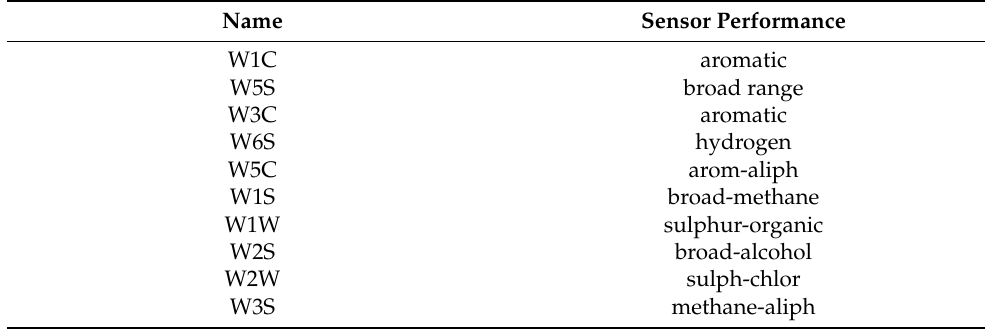
Table 2. Performance of the electric nose